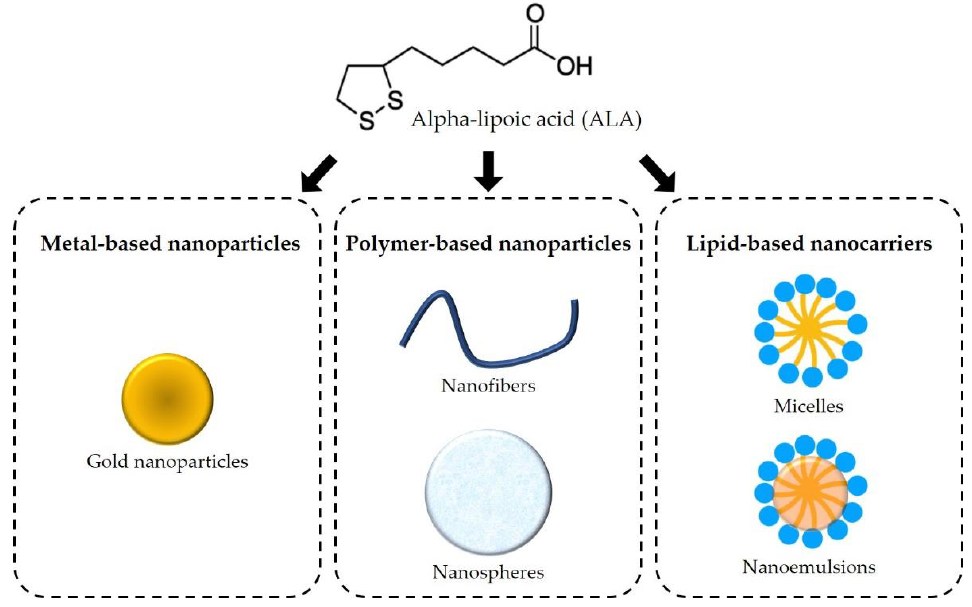
Figure 4. Schematic of the main nanotechnological approaches using alpha-lipoic acid.